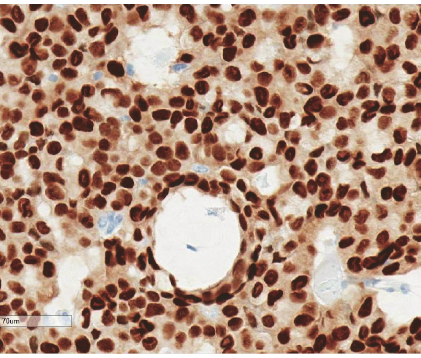
Figure 5: Positive estrogen receptor staining (90–100%).